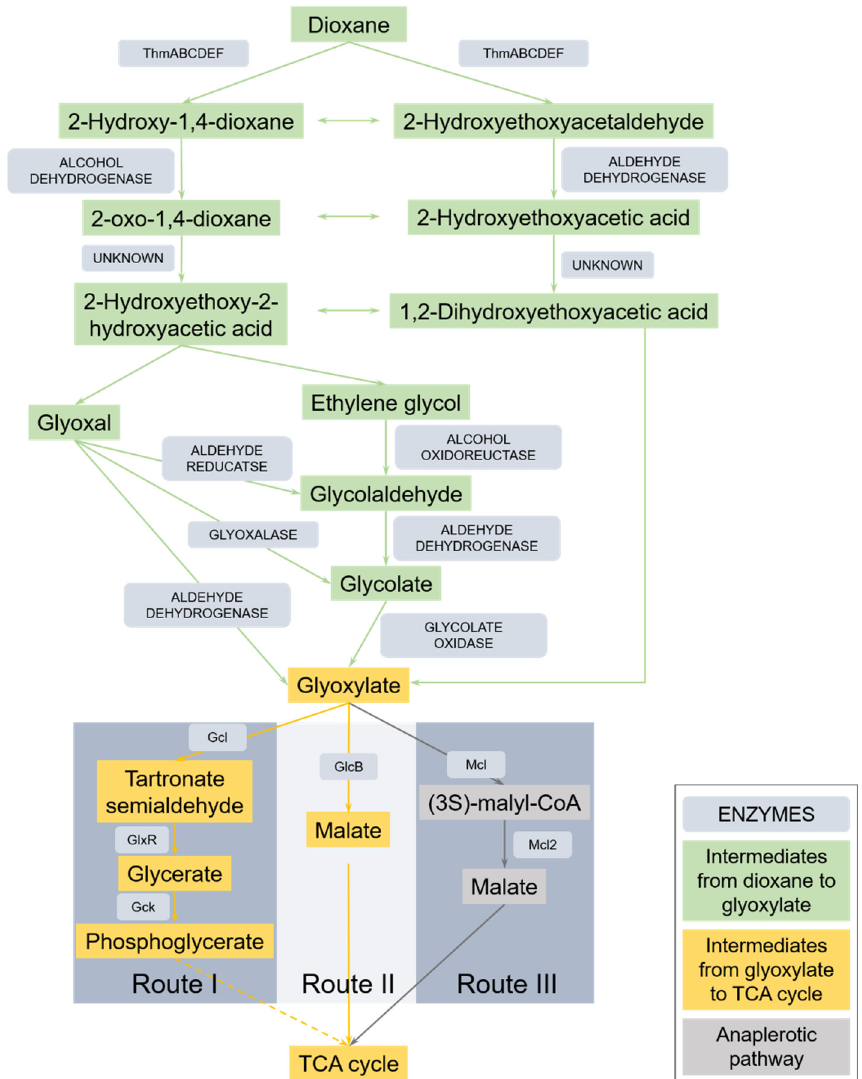
Figure 4. Proposed dioxane metabolic pathway in Xanthobacter sp. YN2 based on the results in the present study and existing research. The dashed arrow indicates multistep transformations. Gcl, glyoxylate carboligase; GlxR, tartronate semialdehyde reductase, Gck, glycerate 2-kinase; GlcB, malate synthase; Mcl, malyl–CoA lyase; Mcl2, (3S)-malyl–CoA thioesterase.